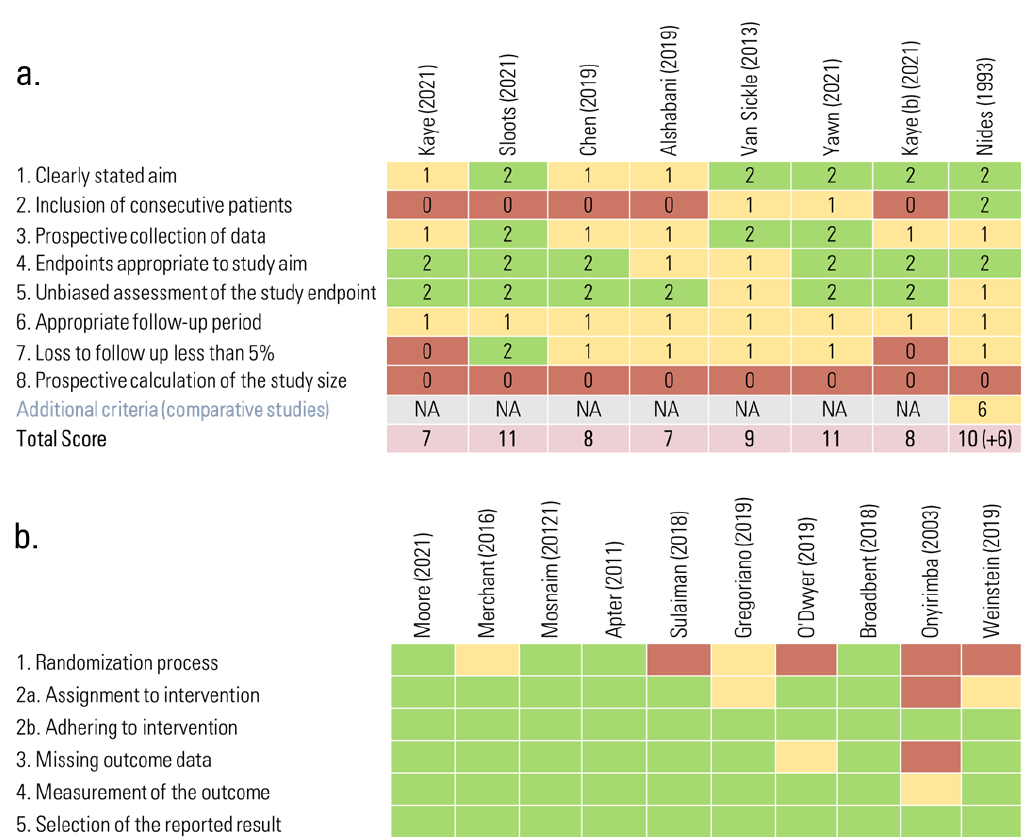
Figure 4. Risk-of-bias assessment. ( a ) Observational studies; ( b ) clinical trials. NA: not applicable.